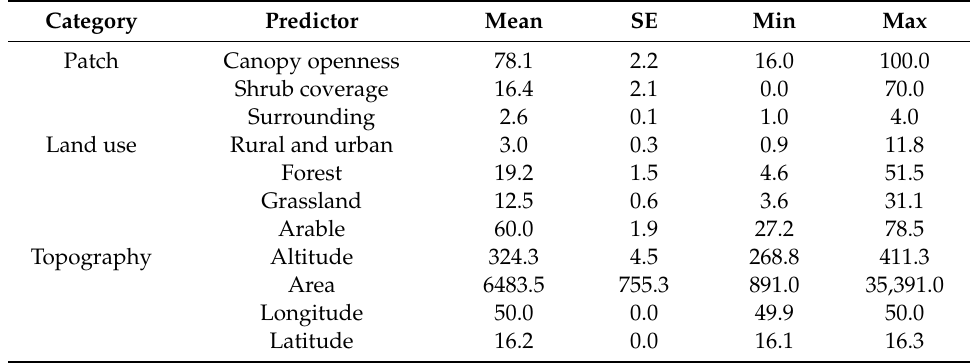
Table 1. Discrimination among predictor categories used in this study and their values (mean, standard error, minimum and maximum) in the 68 studied traditional fruit